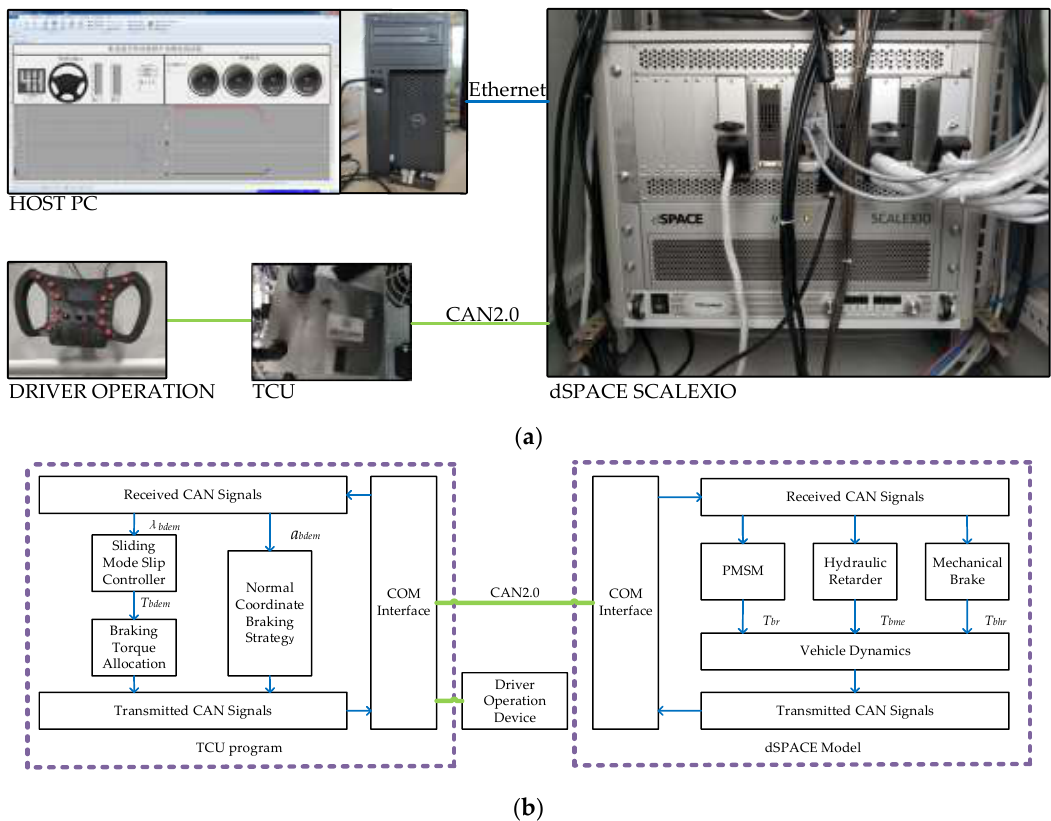
Figure 9. Schematic diagram of HIL experiment setups: ( a ) is the hardware level and ( b ) is the software level.